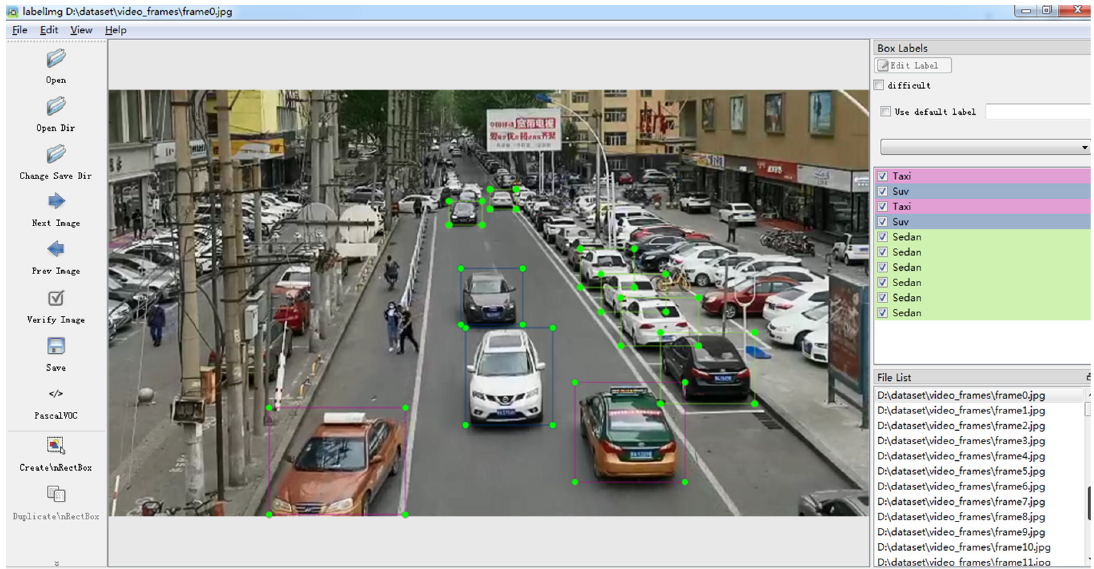
Figure 2. Labelling of vehicles with image label software.